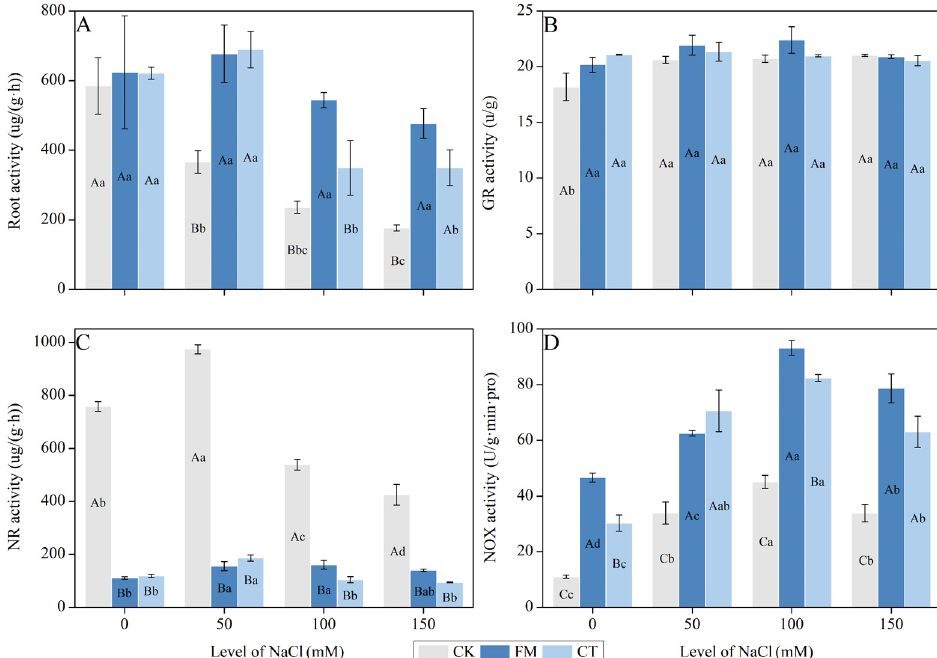
Figure 4. Variations in root physiological characteristics between treatments. ( A ) root activity of